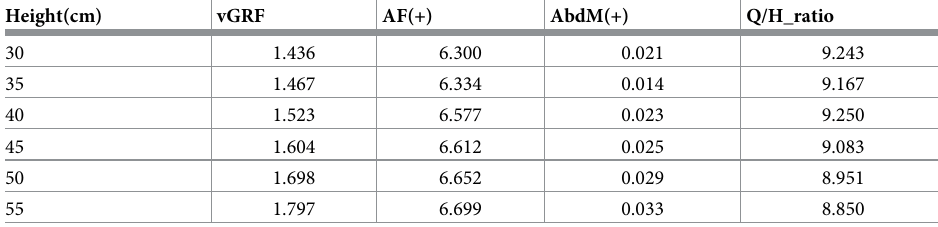
Table 2. Vertical GRF, AF, AbdM and Q/H force ratio at peak vGRF time instance for multiple drop-landing